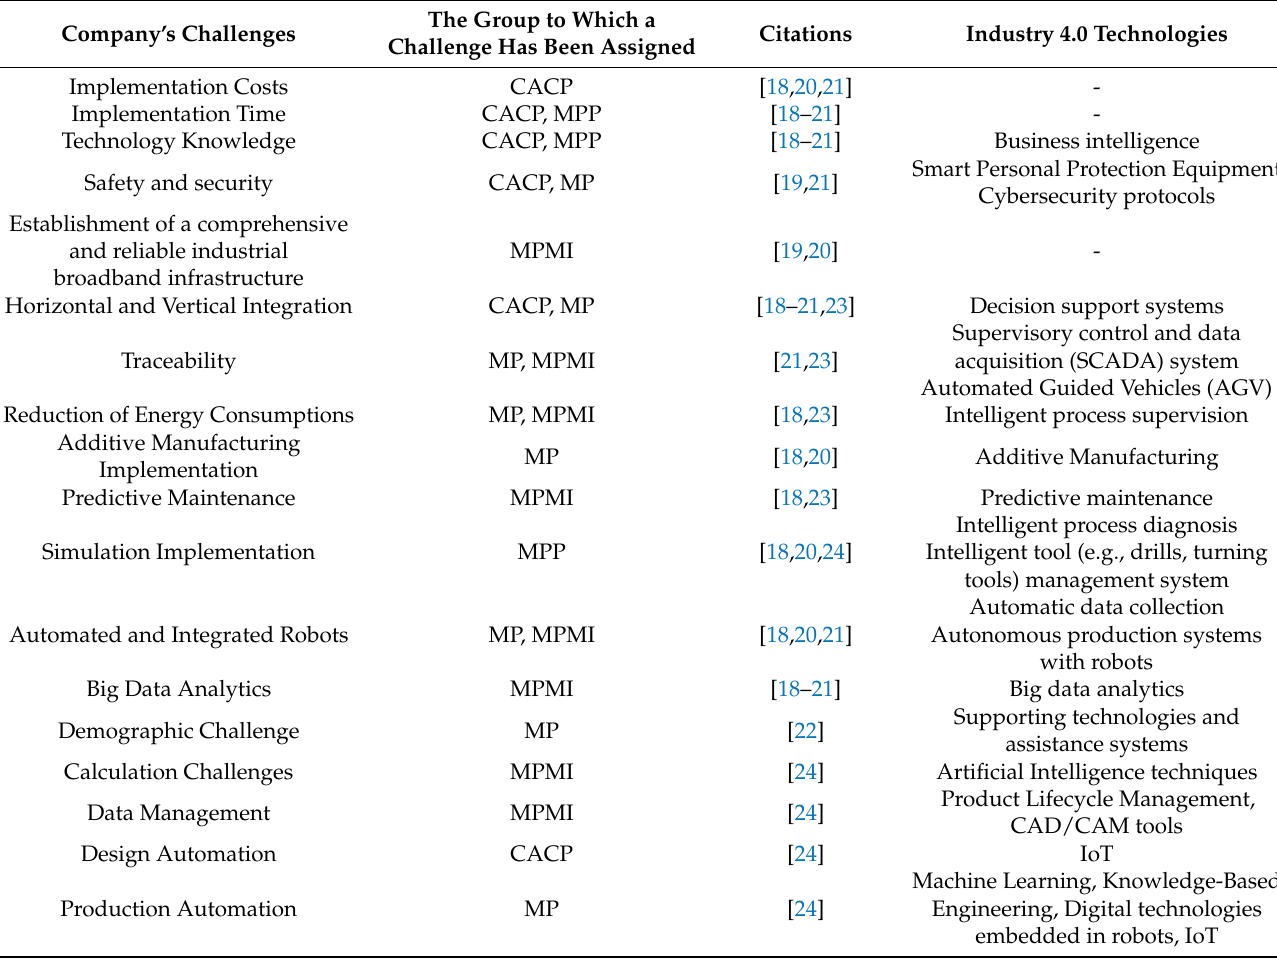
Table 1. Company Challenges from articles of literature review; CACP—customer acquisition and contract planning, MPP—manufacturing process preparation, MP—manufacturing process, MPMI—manufacturing process monitoring and